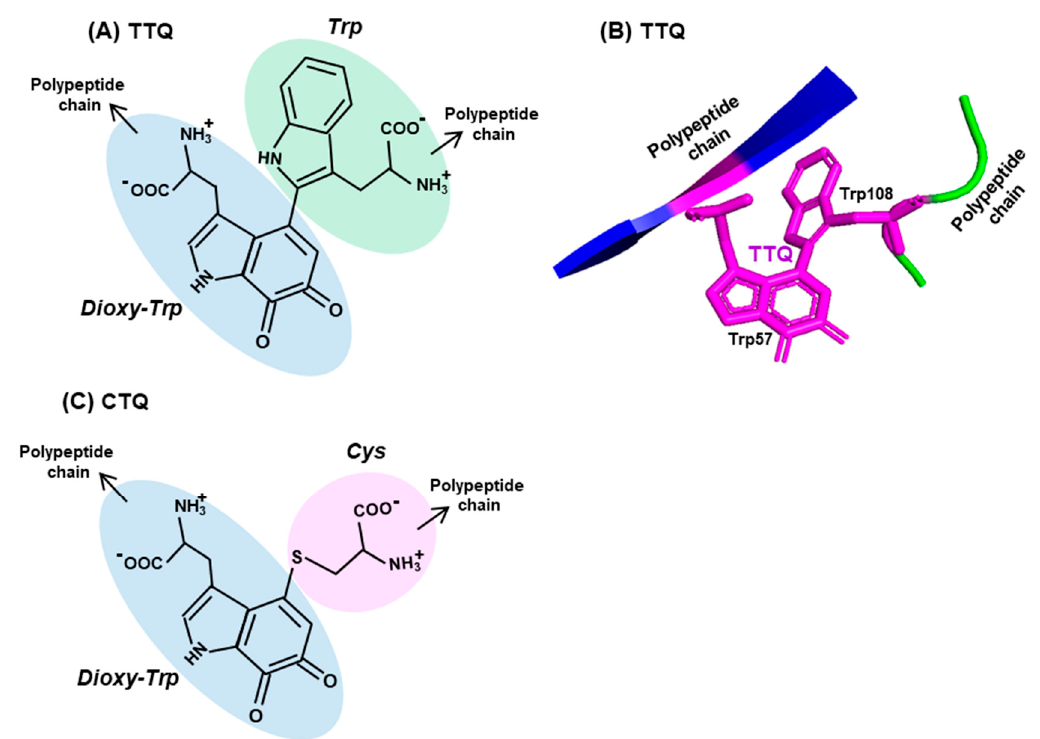
Figure 3. Two representative Trp adducts. Structures of two adducts, ( A ) tryptophan tryptophylquinone (TTQ) and ( C ) cysteine tryptophylquinone (CTQ) are shown, with each amino acid moieties circled in different colors (three Trp, one Cys), the dioxy-derivative of Trp being blue (compare with the Trp structure in Figure 2). Both TTQ and CTQ are part of the polypeptide chain, the continuity of which is indicated by arrowheads. PyMol representation of TTQ in the PDB entry 2BBK is shown in ( B ).